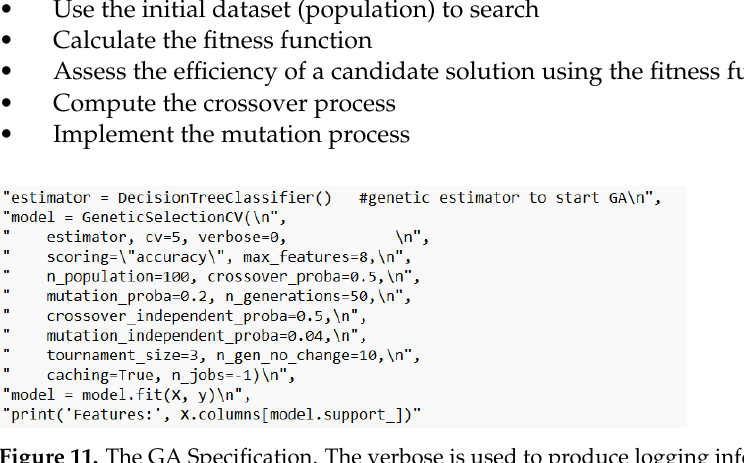
Figure 11. The GA Specification. The verbose is used to produce logging information details and the tournament to select individual attributes from a population dataset. The tournament is executed three times and the winner of each tournament having the best fitness is